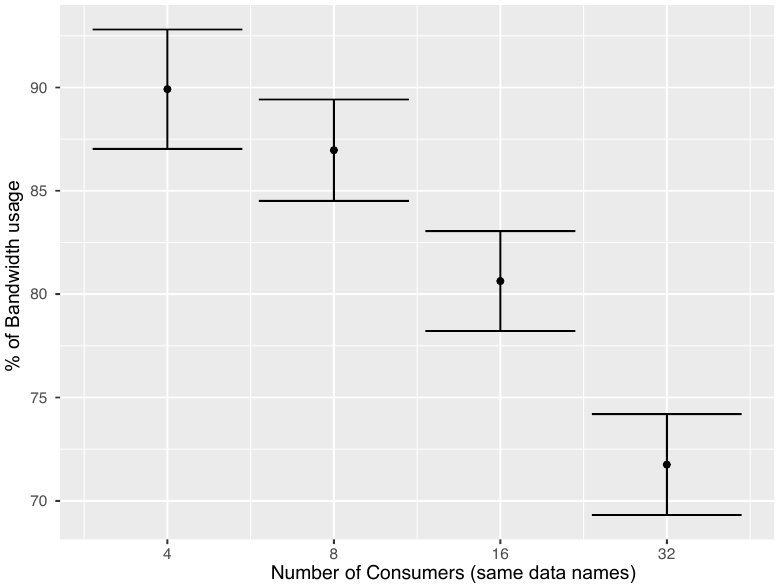
Figure 4. Percentage of bandwidth usage at the producer when consumers require the same data